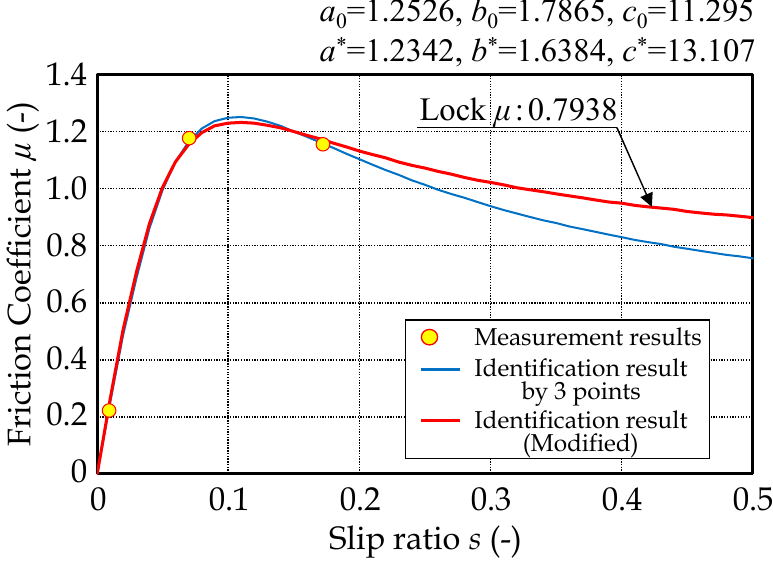
Figure 18. Results of the ‘fine particle asphalt mixture’. Similarly, the results for coarse particle asphalt mixture are shown in Figure 19. In Figure 19 as well, the same analysis as in Figure 18 is performed. From Figures 18 and 19, the change in µ -s characteristics owing to the difference in the surface of the road is clearly represented.